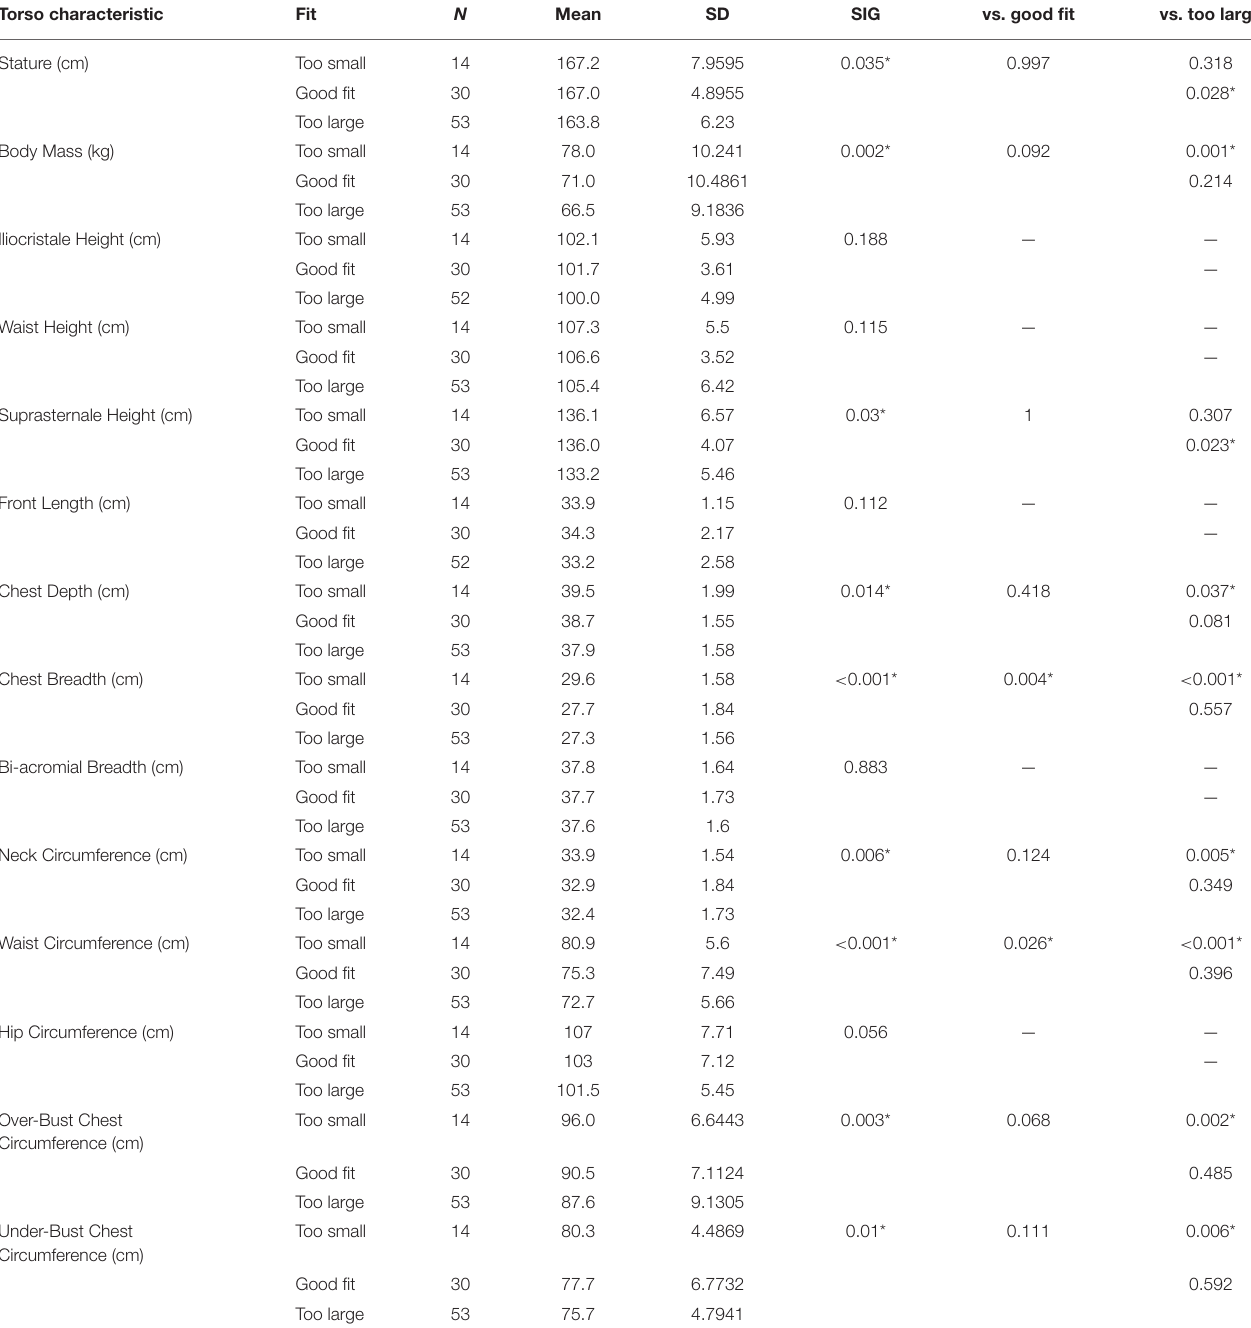
TABLE 5 | Torso characteristic data compared between the three fit groups (too small, good fit, and too large) using One-Way ANOVA (normally distributed data; difference in group means) or Kruskal–Wallis (non-normally distributed data; difference in mean rank). Torso characteristic Fit N Mean SIG vs. good fit vs. too